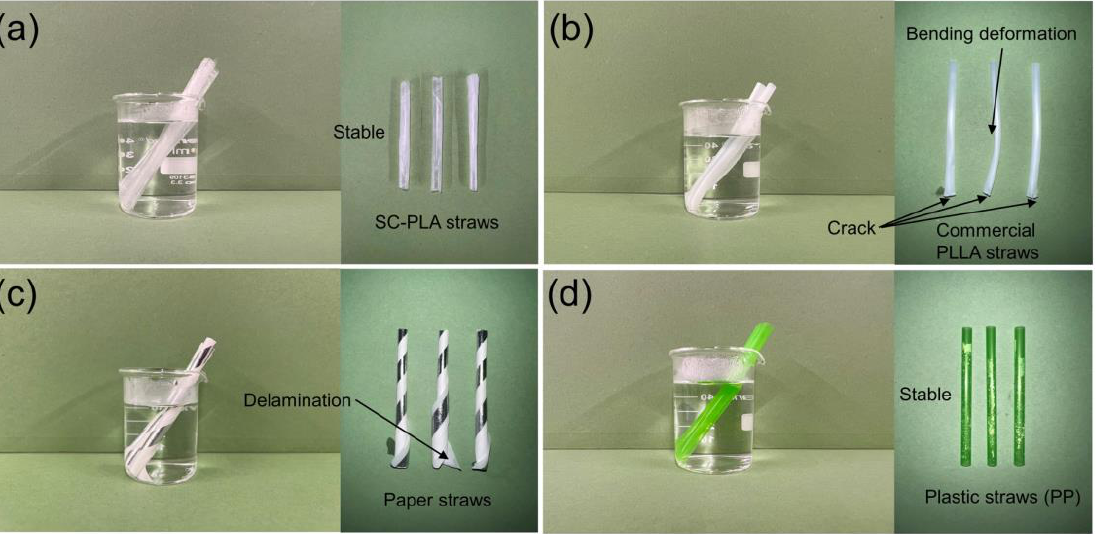
Figure 4. ( a – d ) State of three straws from each group after immersion in hot water at 100 °C for 10 min. Table 2. Comparison of average tensile strength and loss of tensile strength of straws exposed to 100 °C hot water for 10 min.